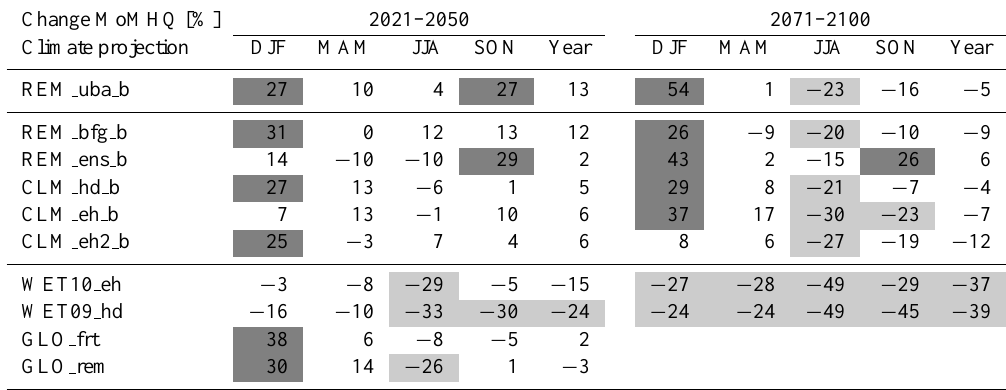
Table 3. Same as Table 2 for mean monthly high flow